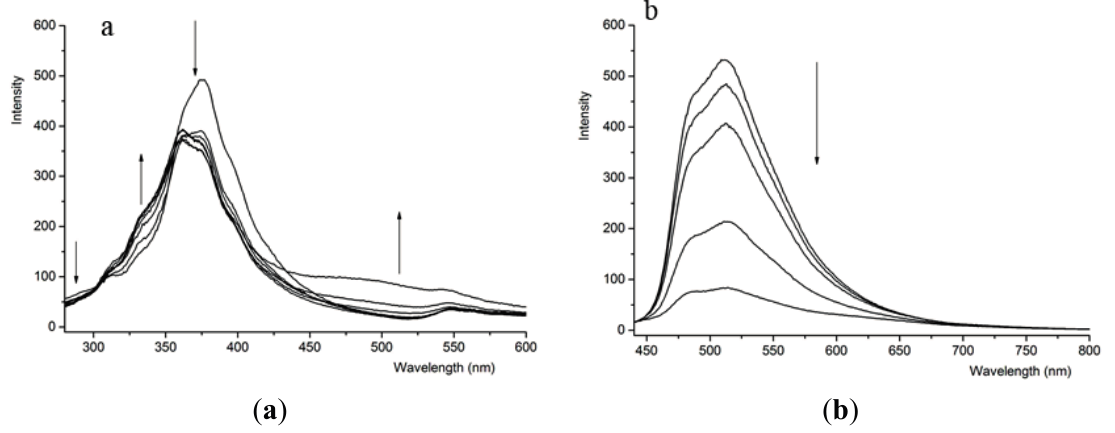
Figure 2. Fluorescence titration of compounds (4.0 × 10 − 5 mol · L − 1 ) with AcO − in DMSO at 298 K. ( a ) 1 ; ( b ) 3